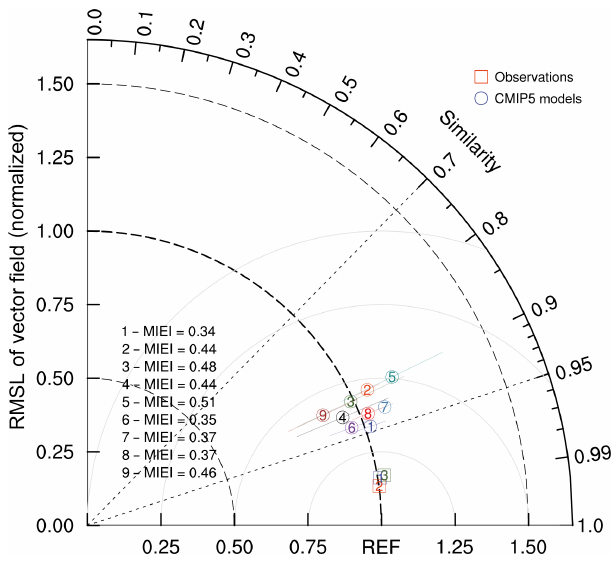
Figure 2. VFE diagram describing the normalized climatological mean SAT, precipitation, and interannual variabilities of SAT and precipitation over a land area between 60 ◦ S and 60 ◦ N simulated by nine CMIP5 models compared with three groups of SAT and precipitation data observed during the period from 1961 to 2000. The RMSL and the RMSVD have been normalized by dividing the RMSL derived from the observed data. The line segment centered at each plotted point along the azimuthal direction represents 2 stan- dard deviations of the rms values of various fields. The value of the MIEI for each model is also shown in the